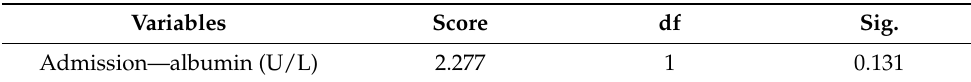
Variables Score df Sig. Admission—albumin